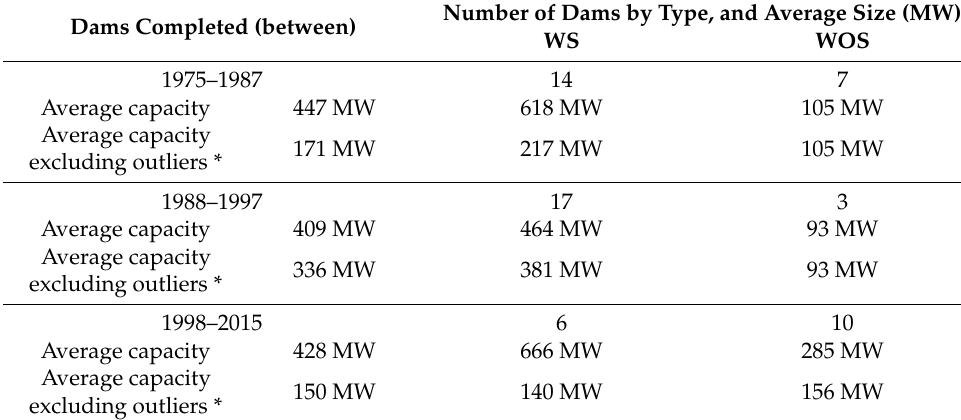
Table 7. Type and size of the dams for different periods.